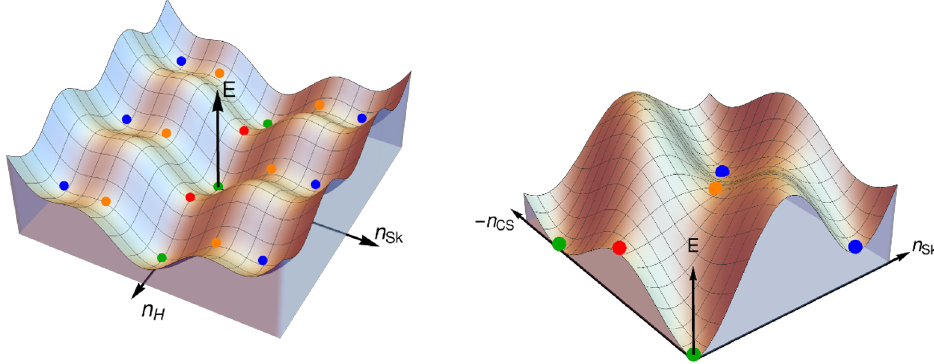
Figure 1 . The energy profile of finite-energy field configurations parameterised by the ( n H , n Sk ) coordinates in the plot on the left figure and by ( n CS , n Sk ) in the figure on the right. Green dots are the pure-gauge vacuua with n H = n CS ∈ Z and n Sk = 0 , red dots are the sphalerons, blue dots are the skyrmion and anti-skyrmion configurations n Sk = ± 1 along with their large gauge transformations. Orange dots indicate the barriers at n Sk = ± 1 / 2 between the vacua and the (anti-)skyrmions. The energy axis E resides at the origin, n H = n Sk = n CS = 0